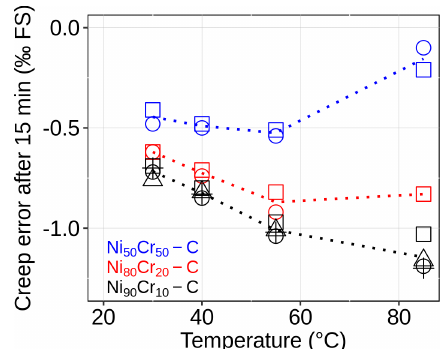
Figure 7. Creep error after 15min of aluminum bending beams with attached thin-film SGs of three different film compositions, which is plotted versus temperature. The films Ni 50 Cr 50 − C, Ni 80 Cr 20 − C and Ni 90 Cr 10 − C were deposited on polyimide type A. Every marker symbol represents a sensor specimen; the dotted lines connect the average values (not shown